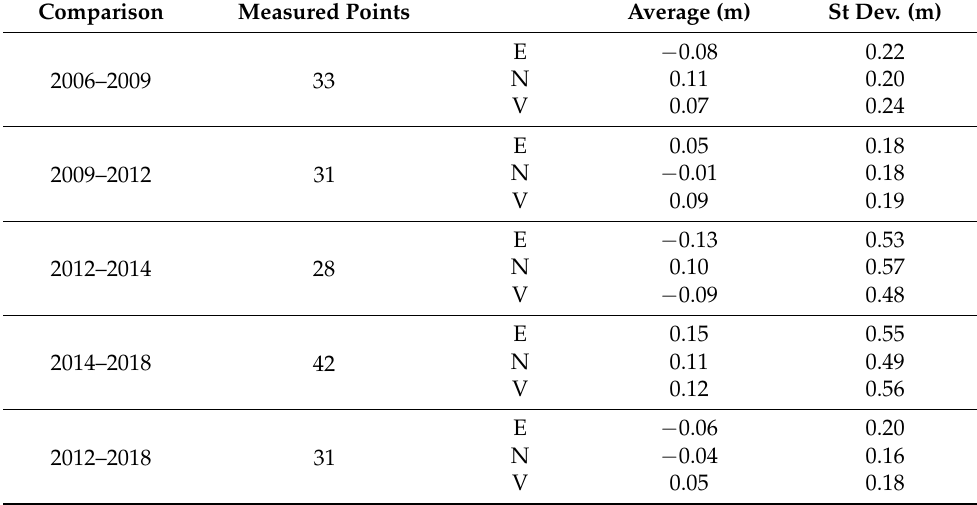
Table 4. Comparisons between coordinates of homologous natural points, manually measured on LiDAR datasets and the photogrammetric model of 2014 using stereoscopic viewing devices (E: East; N: North; V: Vertical; St. Dev.: Standard